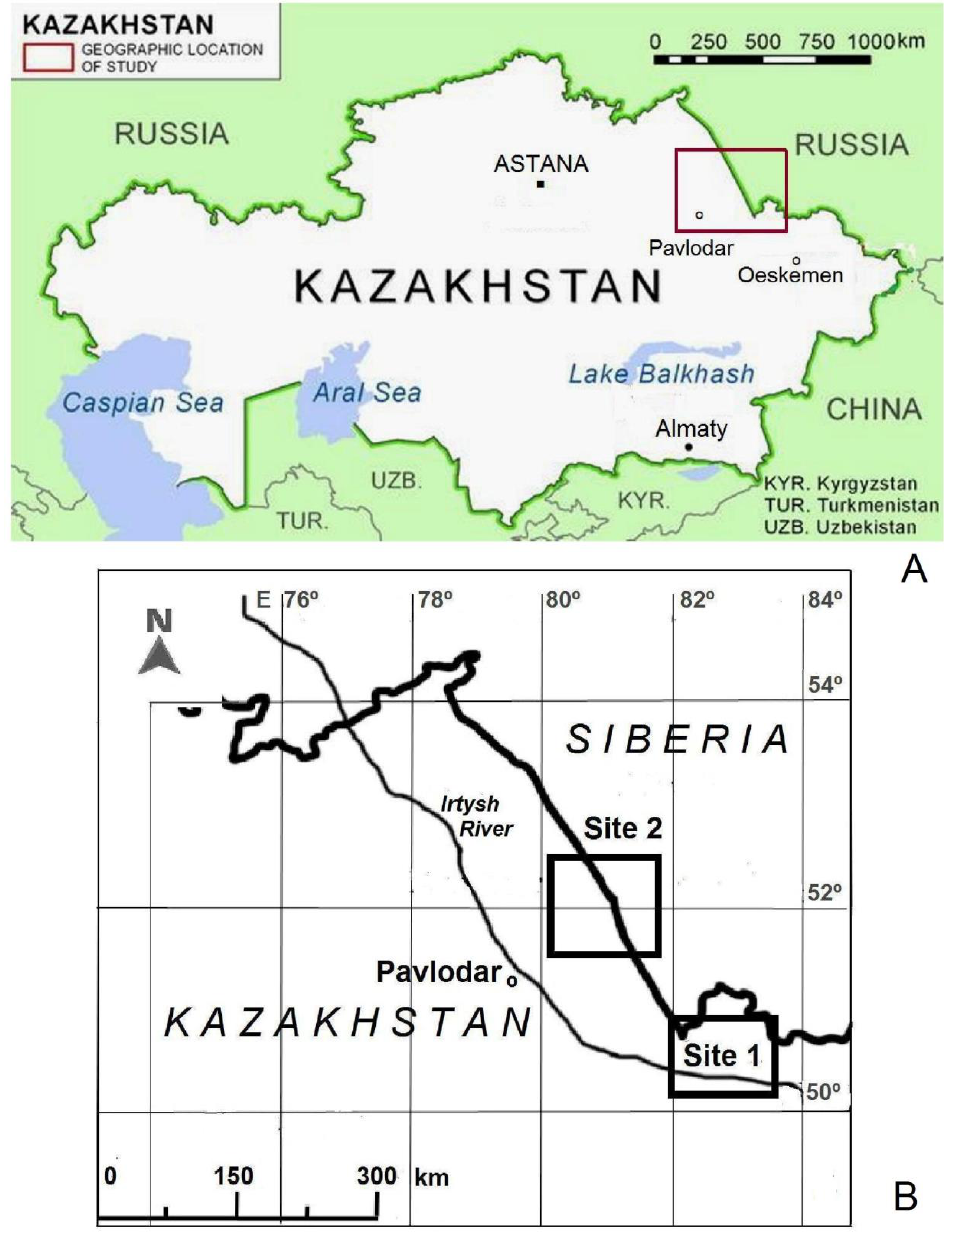
Figure 1. ( A ) The geographical location of the study area in NE Kazakhstan along the Russian (West Siberian) border. ( B ) Location of the two investigated sites in the Beskaragai and Chaldai Nature Reserves,